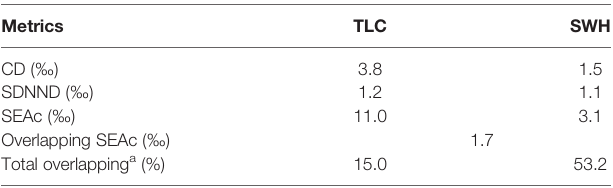
TABLE 2 | Summary of niche community metrics of benthic communities sampled at the relatively unpolluted site TLC and organically enriched site SWH in subtidal sediments of subtropical Hong Kong.